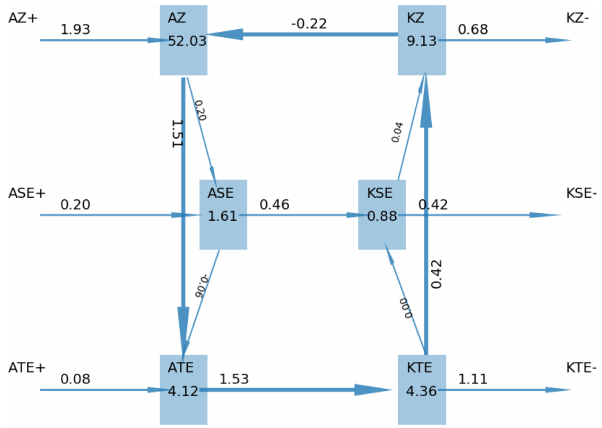
Figure 5. Diagram of Lorenz energy cycle (LEC) annual mean pro- duction, dissipation, storage and conversion terms for 1 year of the pre-industrial CanESM2 model run. AZ denotes the APE reservoir in the zonal mean flow, and ASE and ATE denote the APE associ- ated with stationary and transient eddies, respectively. KZ denotes the KE associated with the zonal mean flow, and KSE and KTE de- note the KE associated with the stationary and transient eddies (see Appendix A2). Reservoirs are displayed in units of 10 5 joules per square metre and conversion terms as watts per square